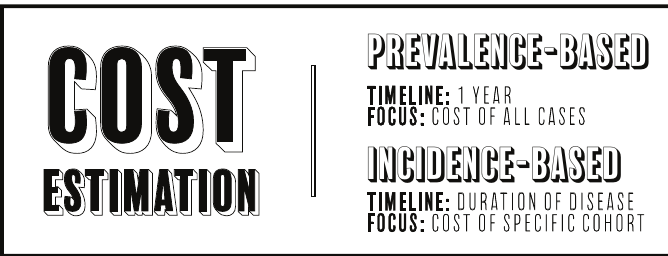
Figure 2. Main cost estimation